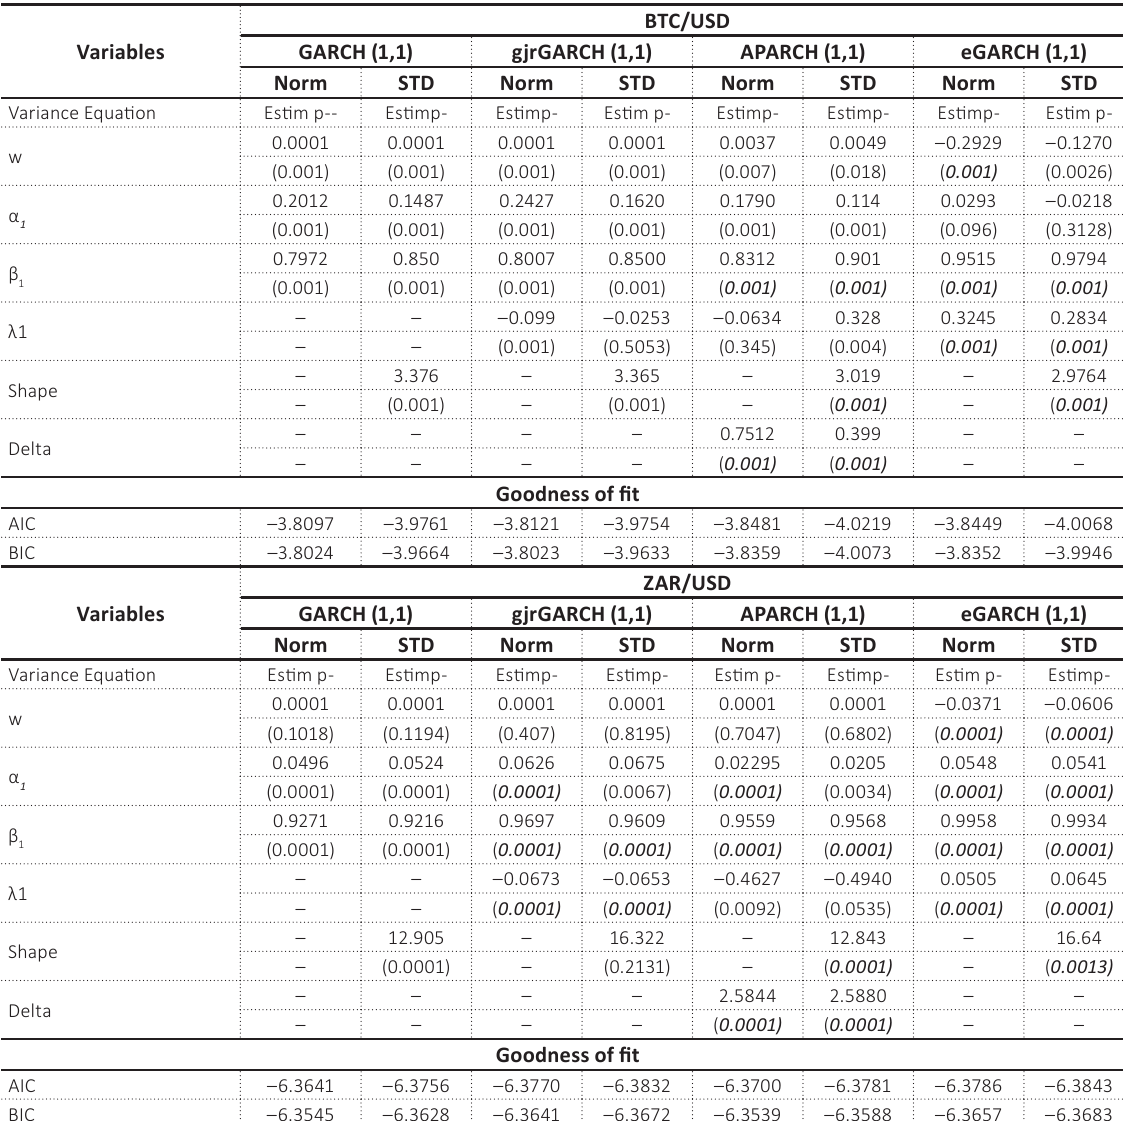
Table 2. Estimated GARCH parameters for both BTC/USD and